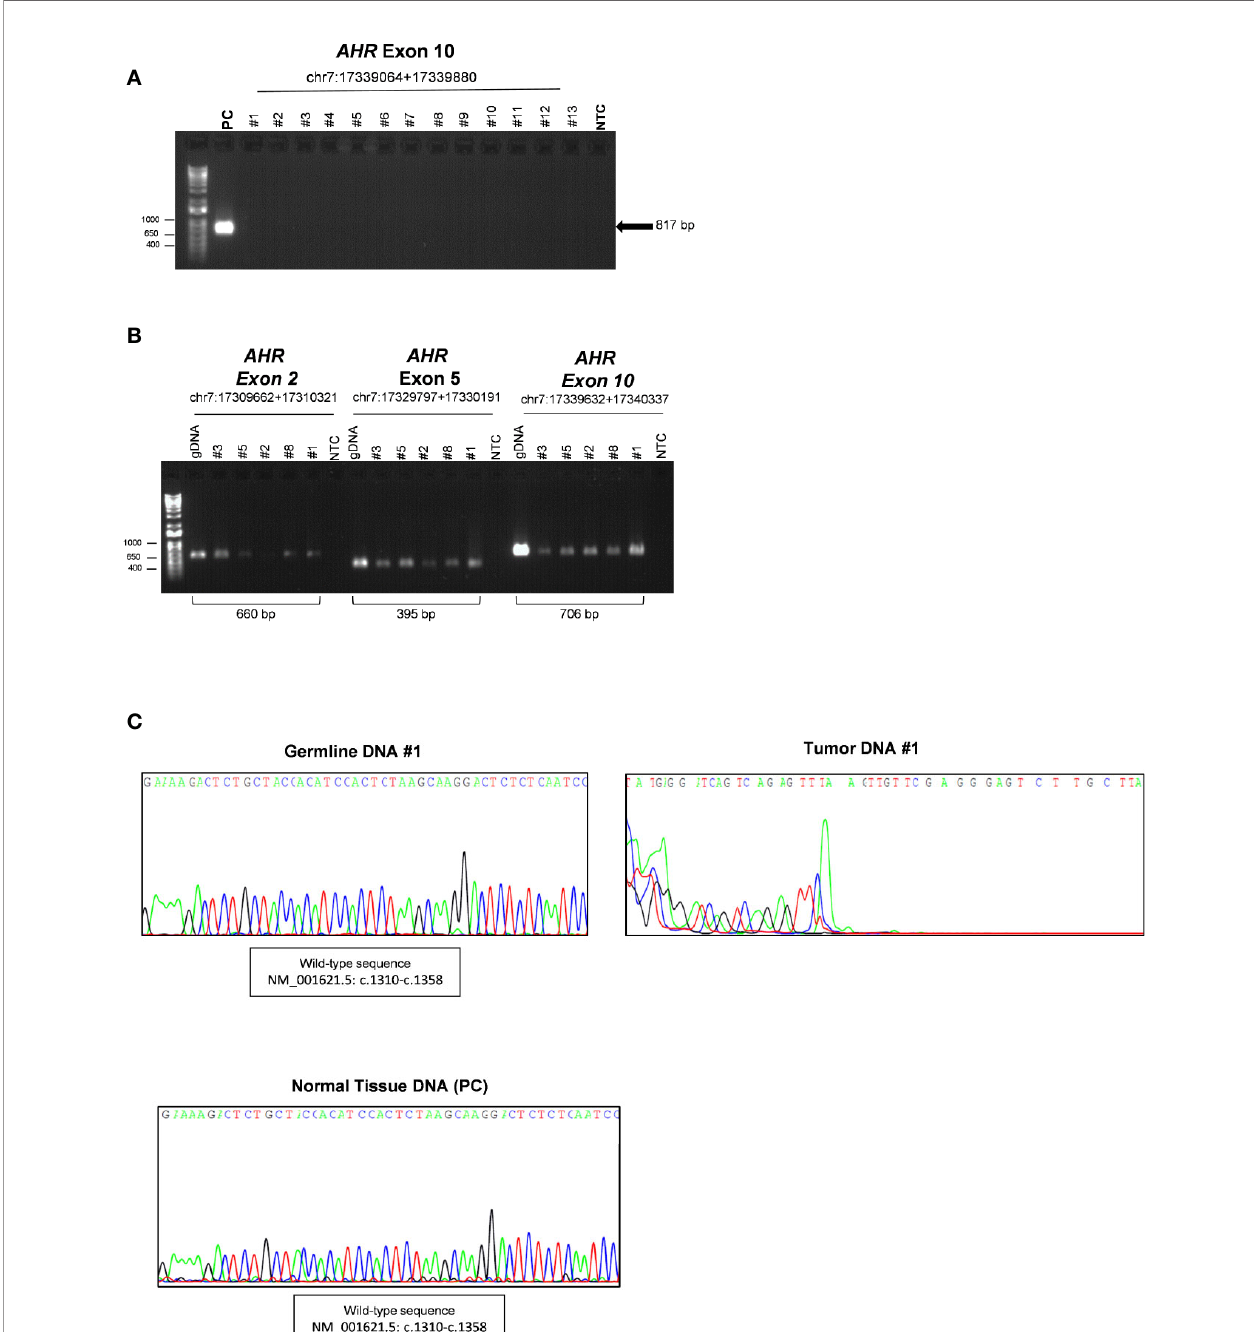
FIGURE 1 | Characterization of somatic aryl hydrocarbon receptor ( AHR ) mutation in Growth Hormone (GH)-secreting pituitary tumors. (A) Image of a DNA 1% agarose gel. The leftmost lane contains DNA ladder (1kb plus). Lane 2 shows 817 base pair ampli fi ed PCR product of AHR exon 10 (chr7:17339064+17339880; c.1239-c.2056) of healthy human pituitary sample use as positive control (PC). The subsequent lanes contain a PCR reaction of DNA extract from tumor tissue of patient with (lanes 3- 7) or without (lanes 8-15) germline polymorphism rs2066853 show lack of detectable ampli fi cation of AHR exon 10. Lane 16 shows negative control (NTC; Non-template control). (B) Image of a DNA 1% agarose gel of representative PCR of germline and tumor DNA for AHR exons 2 (chr7:17309662 +17310321), fi ve (chr7:17329797+17330191) and 10 downstream region (chr7:17339632+17340337; (c.1808-intron 10-11). The leftmost lane contains DNA ladder (1kb plus). Lanes 2, 9 and 16 show PCR product of germline DNA (gDNA) as reference control. Lanes 3-7, 10-14 and 17-21 shown PCR product of tumor DNA of patient #3, #5, #2, #8 and #1. Lanes 8, 15 and 22 show negative control without DNA template (NTC; Non-template control). (C) Representative sequence analysis of AHR exon 10. Electropherograms show the sequence of codon site c. 1310-c.1358 in germline (left panel) and tumor tissue DNA from the patient #1 (right panel), and healthy pituitary sample (lower panel), use as positive control